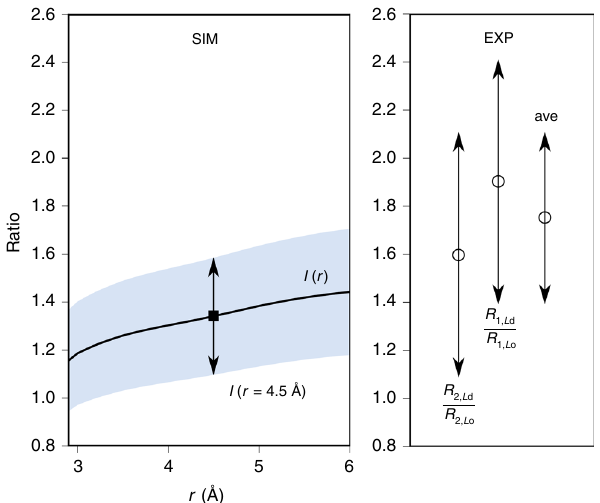
Fig. 8 Relative oxygen population near bilayer midplanes. Left panel: simulated I(r) , the ratio of (normalized) oxygen population near the probe in the L d and L o phases (Eq. (1)) as a function of the interaction radius r between the methyl carbon of chain 2 of DPPC and oxygen, with I(r = 4.5 Å ) shown explicitly ( fi lled square). The blue band is twice the standard error over the four replicas. Right panel: experimental ratios of R 1 ; Ld = R 1 ; Lo , = R R 2 ; Ld 2 ; Lo , and their average (open circles). The uncertainties are standard errors from the fi ts. The source data are provided as a Source Data fi